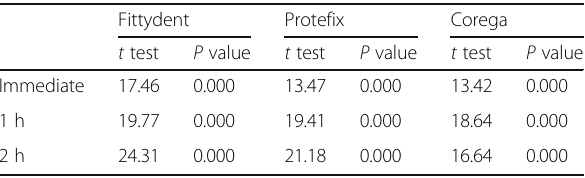
Table 2 Comparison of dislodgement forces of poorly fitting mandibular complete dentures without adhesive and with the use of three types of denture adhesives at various time